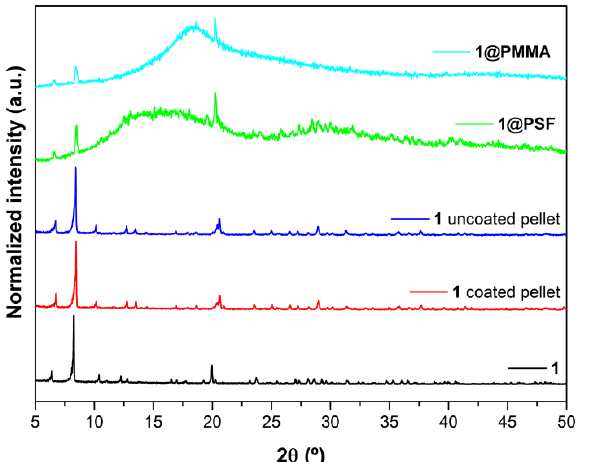
Figure 3. Powder X-ray diffractograms of the studied materials, as-synthesized and after processing into pellets and membranes.